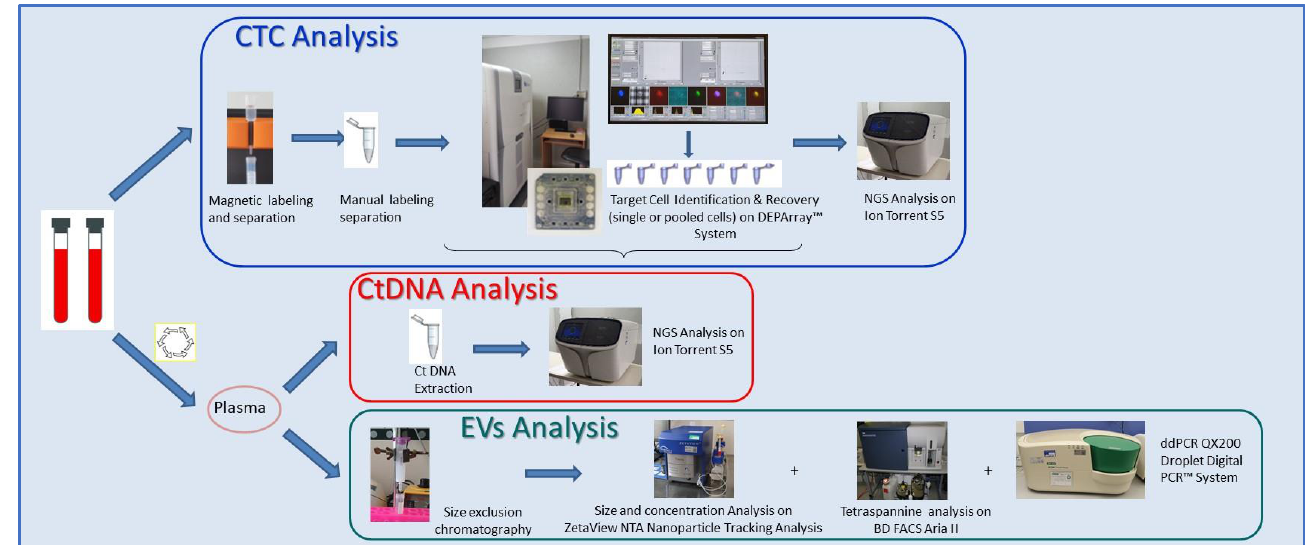
Figure 4. Schematic representation of the parallel analytical workflows performed for ctDNA, CTC, and EV analyses.